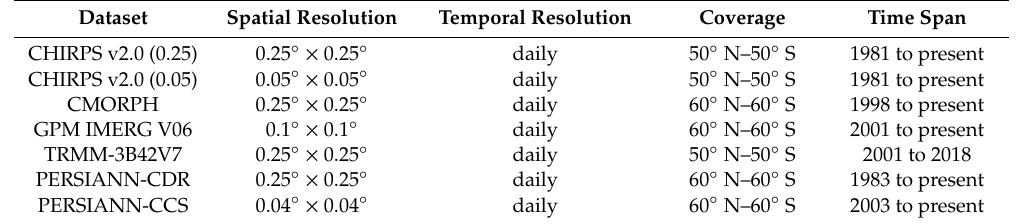
Table 1. Basic information of seven satellite precipitation